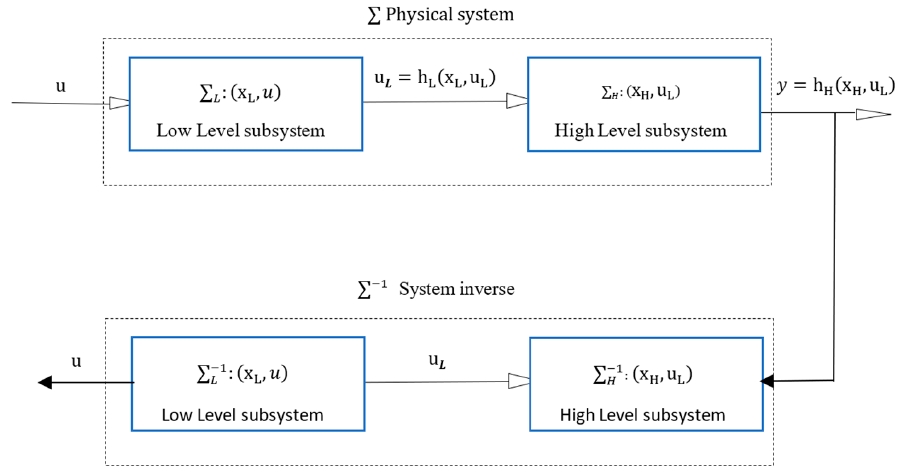
Figure 3. Scheme of the inverse of an interconnected system.